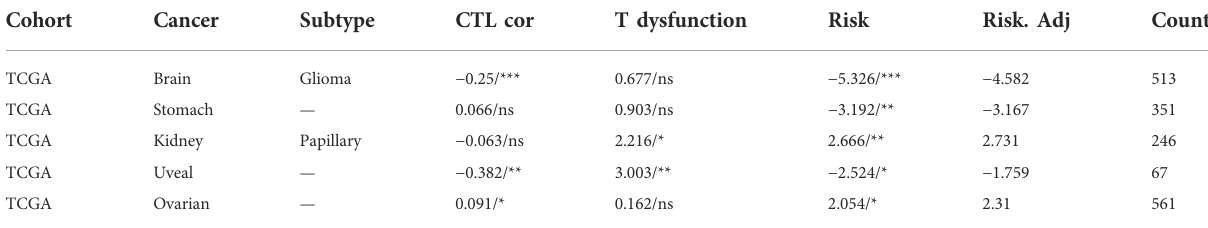
TABLE 1 Associations of CD8A epigenetic modi fi cations with cytotoxic T lymphocytes (CTLs) levels, and T cell dysfunctional states, with Cox proportional hazard (Cox-PH) model regression presenting the role of CD8A methylations in in fl uencing the interactions between CTL